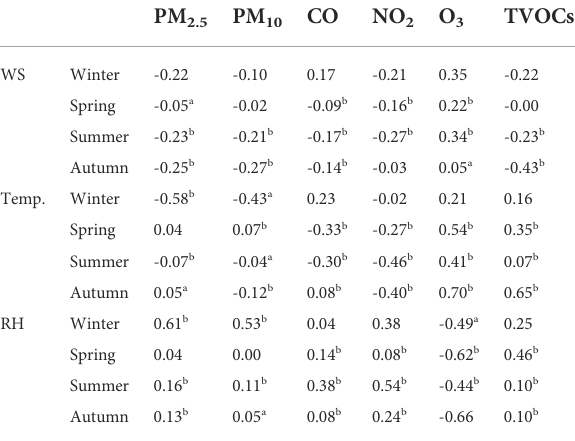
TABLE 2 Summary of pearson correlation coef fi cient values between air pollutants and temperature, RH and